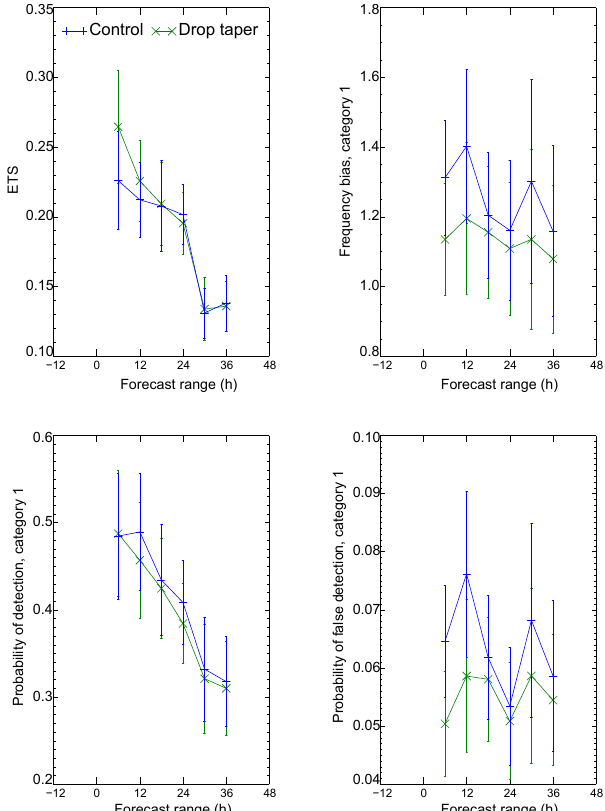
Figure 12. NWP model verification of visibility from 5 February to 5 March 2015 utilising all observations and forecasts (4 per day) over UK land areas. Panels show the equitable threat score (ETS), frequency bias, probability of detection and probability of false de- tection, for a visibility threshold of 200m, from the UKV control (blue) and with modified droplet number